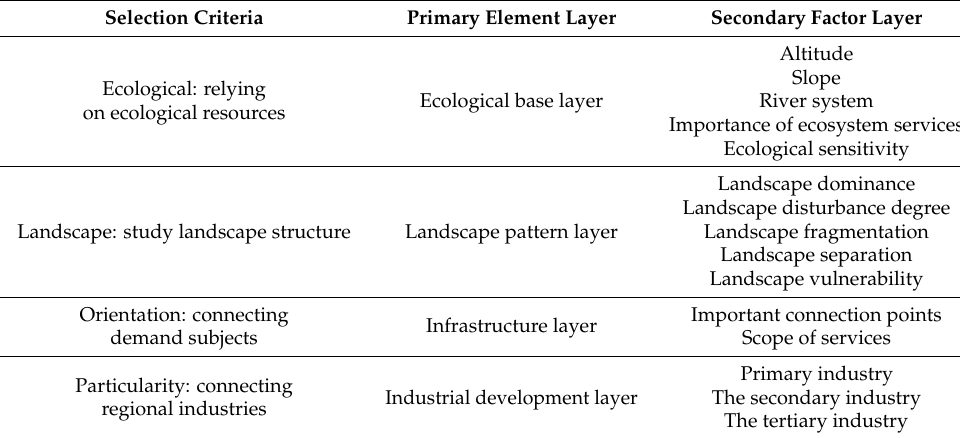
Table 1. Determination of the construction elements and factors for the bamboo forest scenic lines in Sichuan